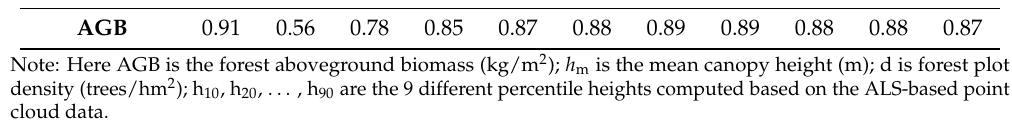
Table 4. The correlation analysis between field-based AGB and ALS-based canopy metrics at forest plot level. ALS Metrics h m